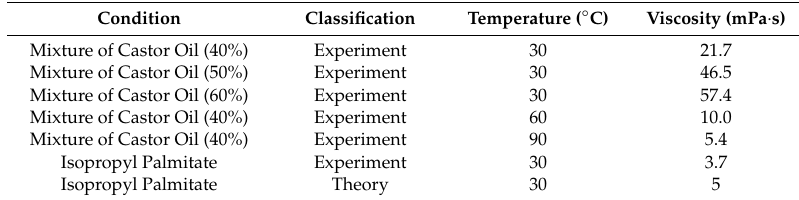
Table 1. Viscosity under di ff erent conditions.